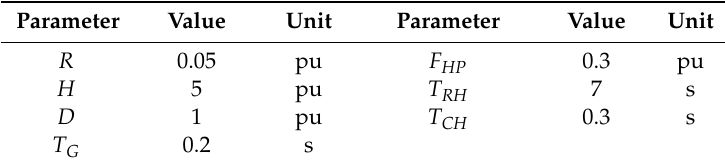
Table 2. Typical parameters of an SG with a reheat steam turbine.